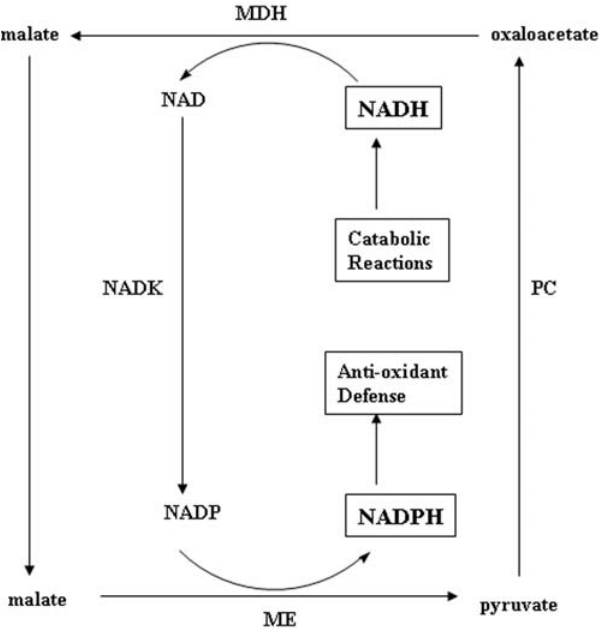
Figure 6. A novel anti-oxidantive defense strategy aimed at converting NADH, a pro-oxidant, into NADPH, an anti-oxidant. MDH=malate dehydrogenase, ME=malic enzyme, PC=pyruvate car- boxylase, and NADK=NAD kinase.